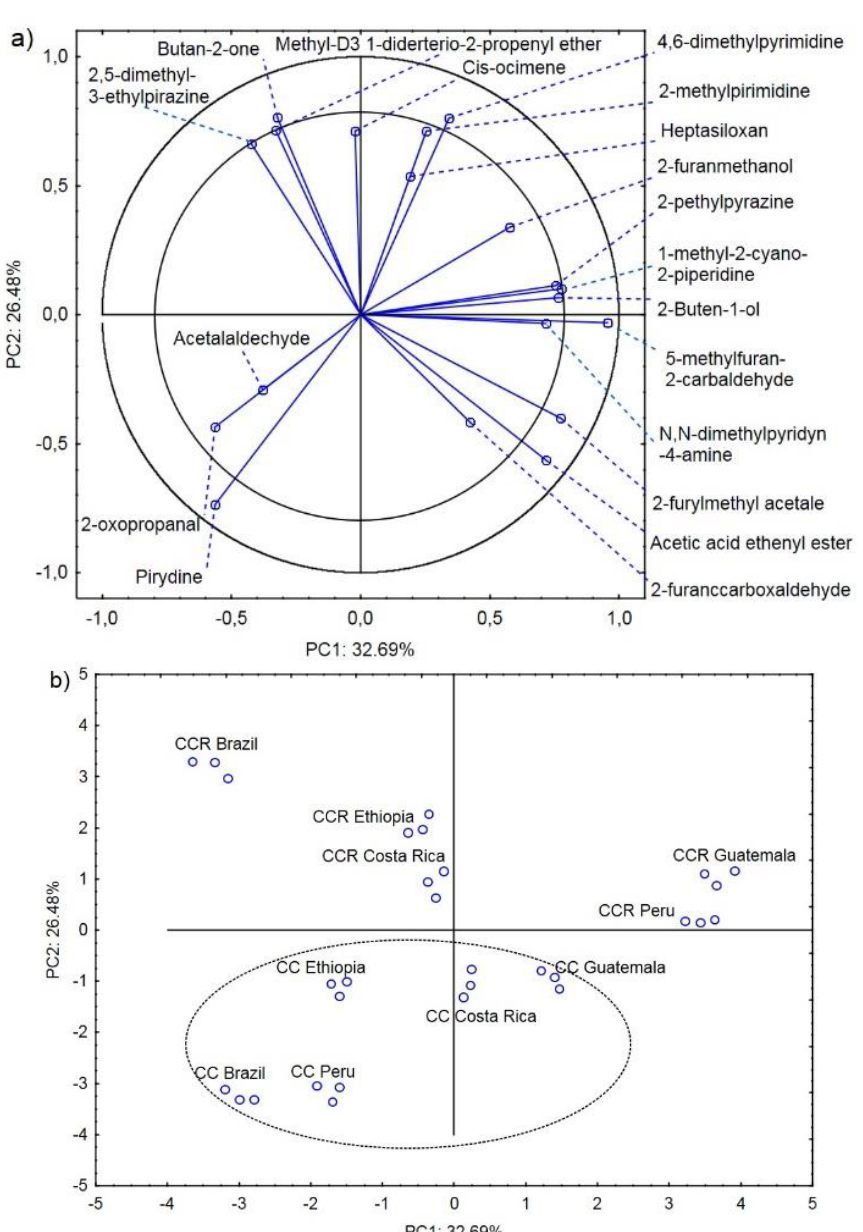
Figure 2. Projection of variables (main volatile compounds characterizing the CC and CCR coffee roasting process) on the PC1 and PC2 factor plane — ( a ); projection of cases (coffee beans from Brazil, Ethiopia, Guatemala, Costa Rica, and Peru roasted in the CC and CCR roasters) on the PC1 and PC2 factor plane — ( b ).